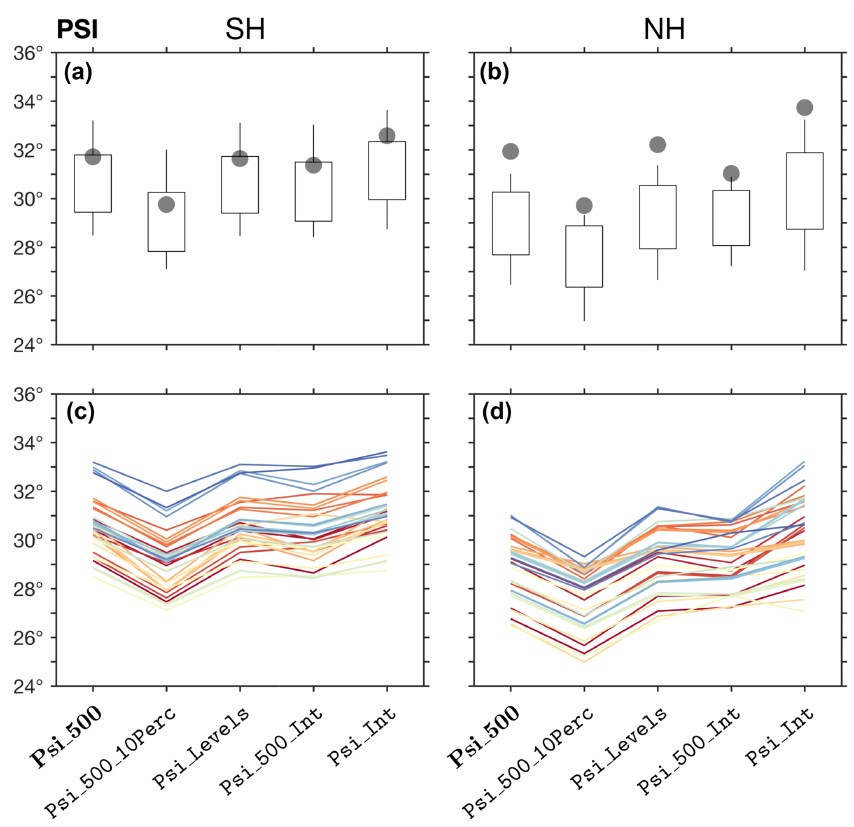
Figure 12. The mean latitude for the five available PSI metric methods, derived from annual means of the zonal-mean meridional wind in the SH (a, c) and NH (b , d) , for the period 1979–2004. The default method ( Psi_500 ) is bolded. Positive values are used for both the NH and SH. In panels (a) and (b) , candle boxes show mean ± 1 standard deviation of CMIP5 inter-model spread; candle wicks show maximal and minimal CMIP5 model values. ERAI values are shown in gray dots. In panels (c) and (d) , values for each model are shown in different colors. The input parameter Lat_Uncertainty is set to zero (default) in all of the methods.